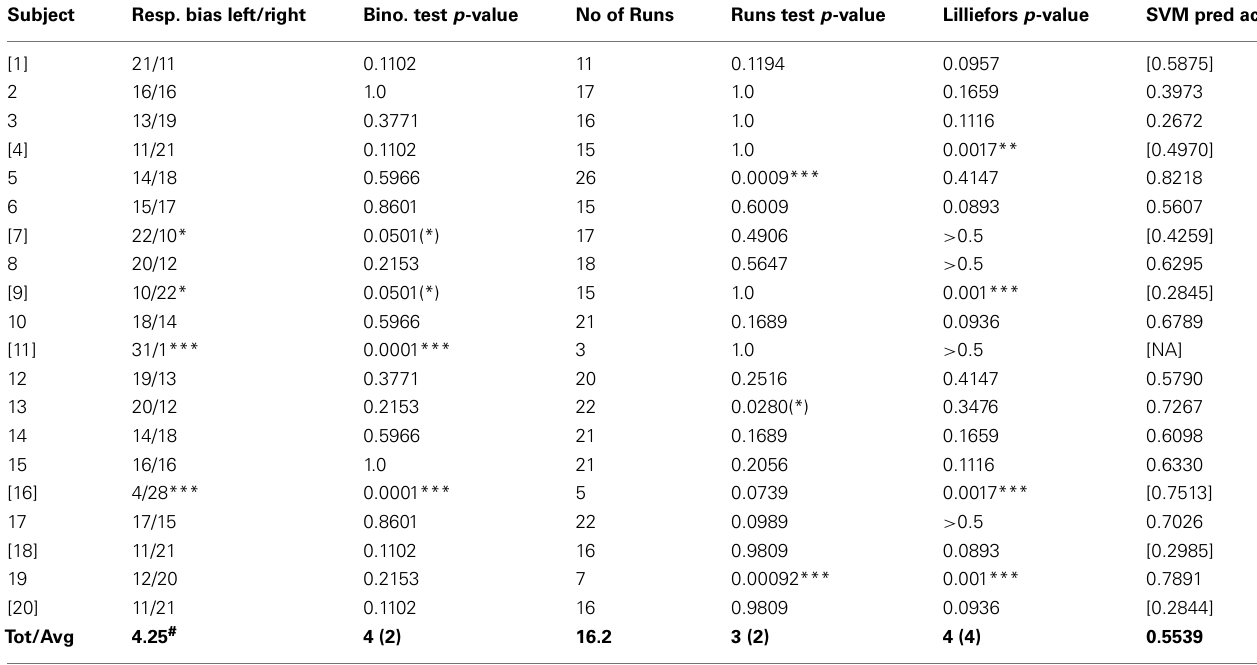
TableA1 | Replication study 1: left/right key press in spontaneous motor decision task.